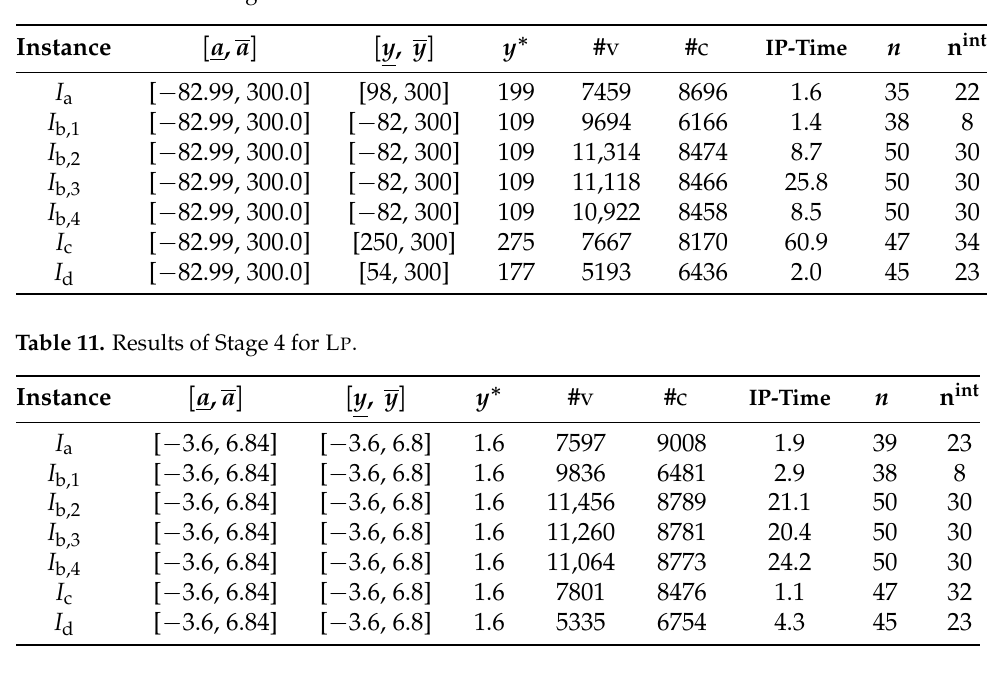
Table 10. Results of Stage 4 for F P .